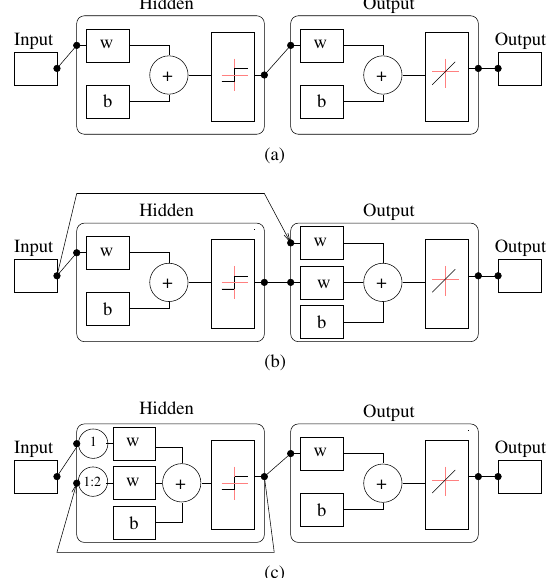
Figure 3. Various artificial neural network (ANN) architectures: ( a ) Feedforward; ( b ) Cascaded; ( c )